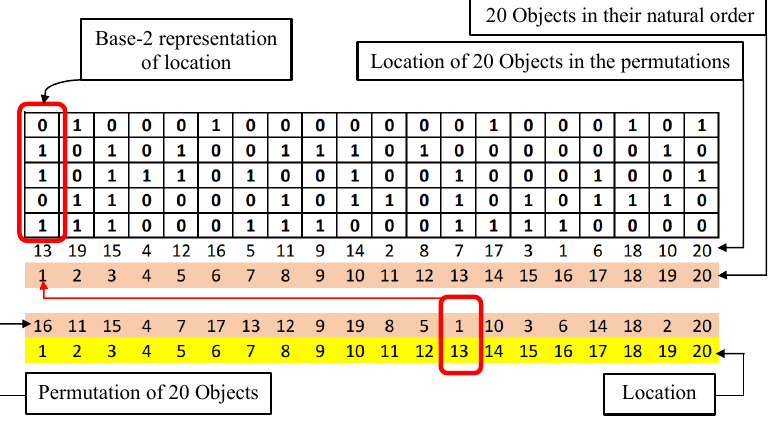
Figure 2. Binary conversion method-2